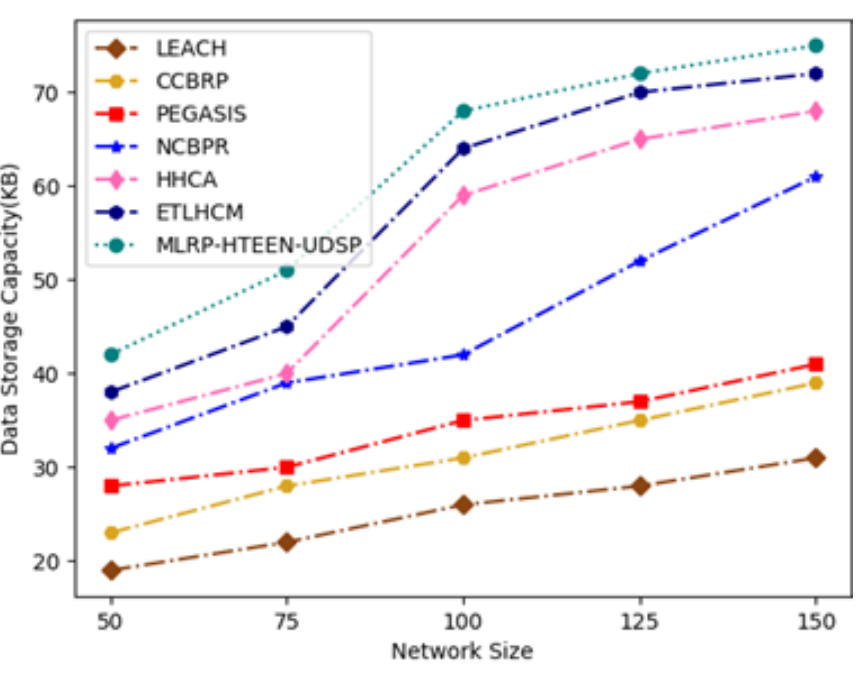
Figure 12. Comparison of data storage.